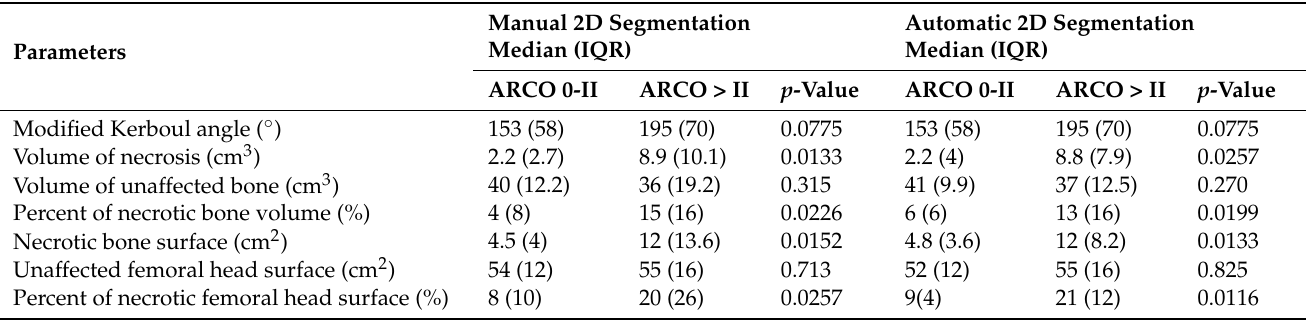
Table 5. Comparison of the manual and automatic segmentation of femoral head necrosis based on 2D MRI between hips with early versus advanced disease stages.